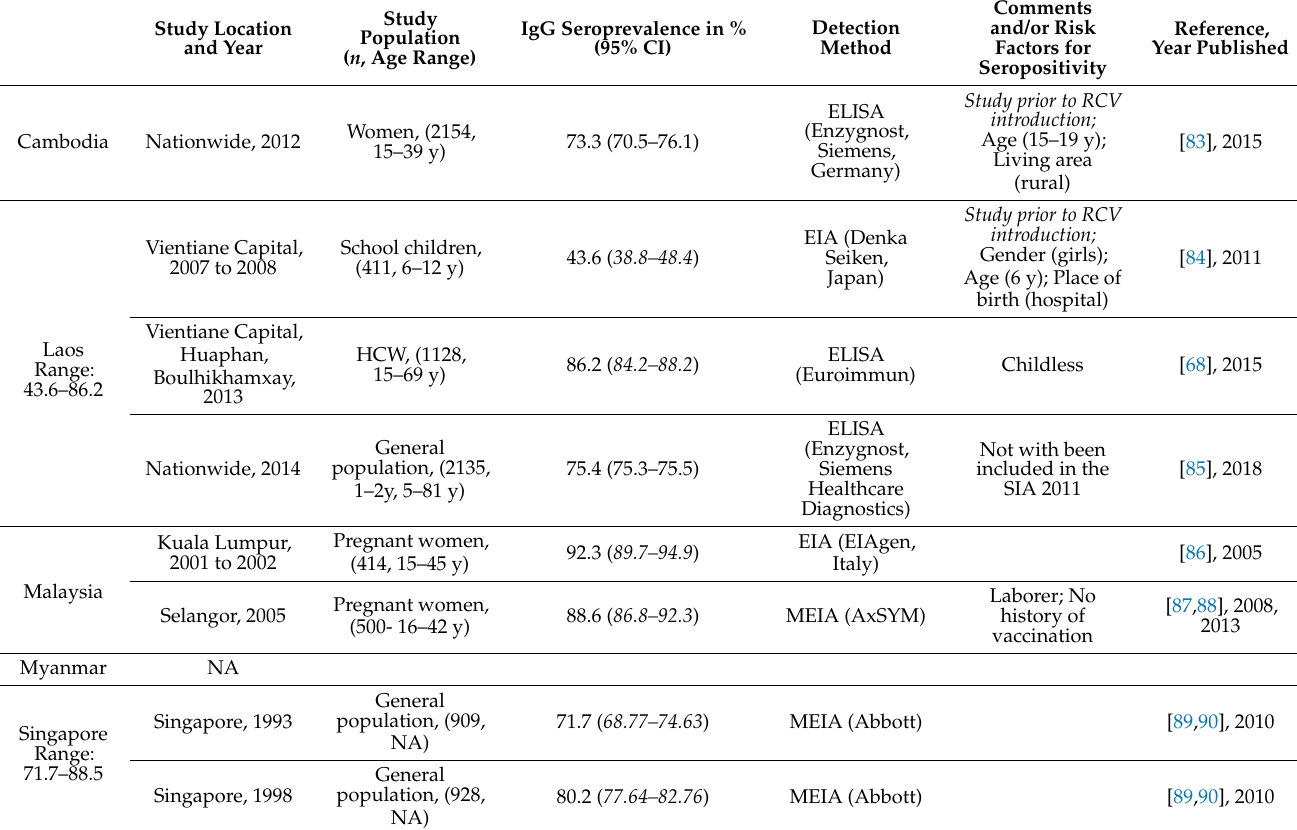
Rubella IgG serosurveys. Confidence Intervals (CI) in Italics estimated as described in Methods, ANC = Antenatal care; EIA = Enzyme immunoassay; ELISA = Enzyme-linked Immunosorbent Assay; HCW = Healthcare workers; MEIA = Microparticle EIA; NA = not available; RCV = Rubella containing vaccine; y =